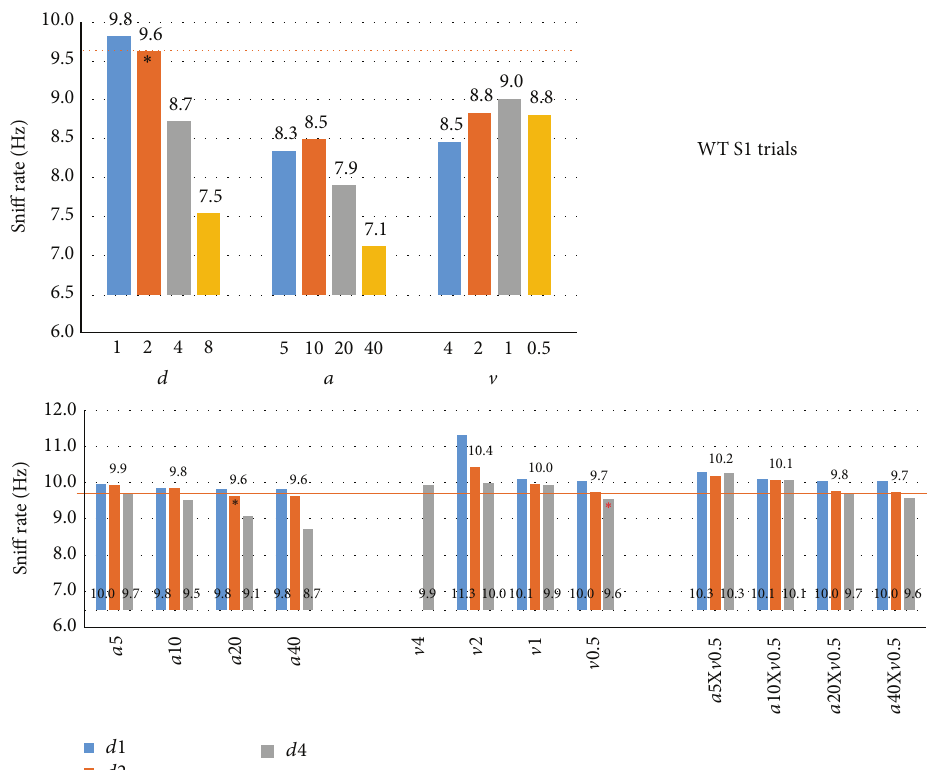
Figure 11: Sniffing rates at targeted criterion thresholds. Sniff rates associated with the same criteria as shown in Figure 10. Top: single criteria;Bottom:combinedcriteria.Relaxedcriterionthresholdsincludebinswithlowsniffratesunrelatedtoodorsourceexploration.Stricter orientation criteria combined with distance < 1cm or < 2 cm do not yield higher sniff rates during exploration (bottom left), but exploration timedropsdramatically(Figure 10,bottomleft).Therelaxedproximitycriterion( < 4cm)combinedwithvelocity > 0.5 cm/s( ∗ ,red)yieldssniff rates equivalent to the standard ( d 2- a 10; 9.6 Hz; bottom center) and also increases exploration time from 11% to 15% (Figure 10),